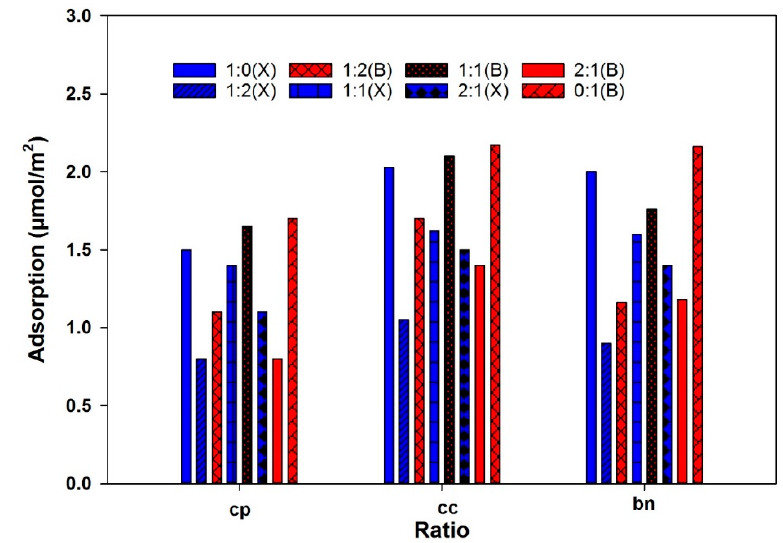
Figure 10. Adsorption of collectors from the mixtures of SIBX(X) and BBT(B) at pH 8.2 and total concentration 3 × 10 − 5 M (SIBX and BBT were added simultaneously). cp-chalcopyrite, cc-chalcocite, bn-bornite.